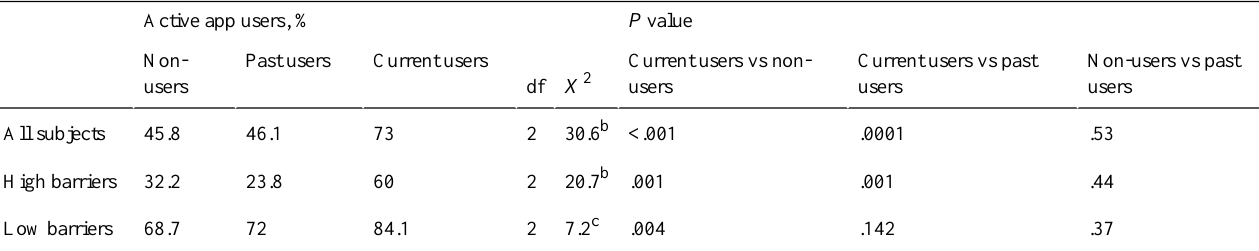
Table 2. Percent of active participants for three app use groups across two levels of barriers. a